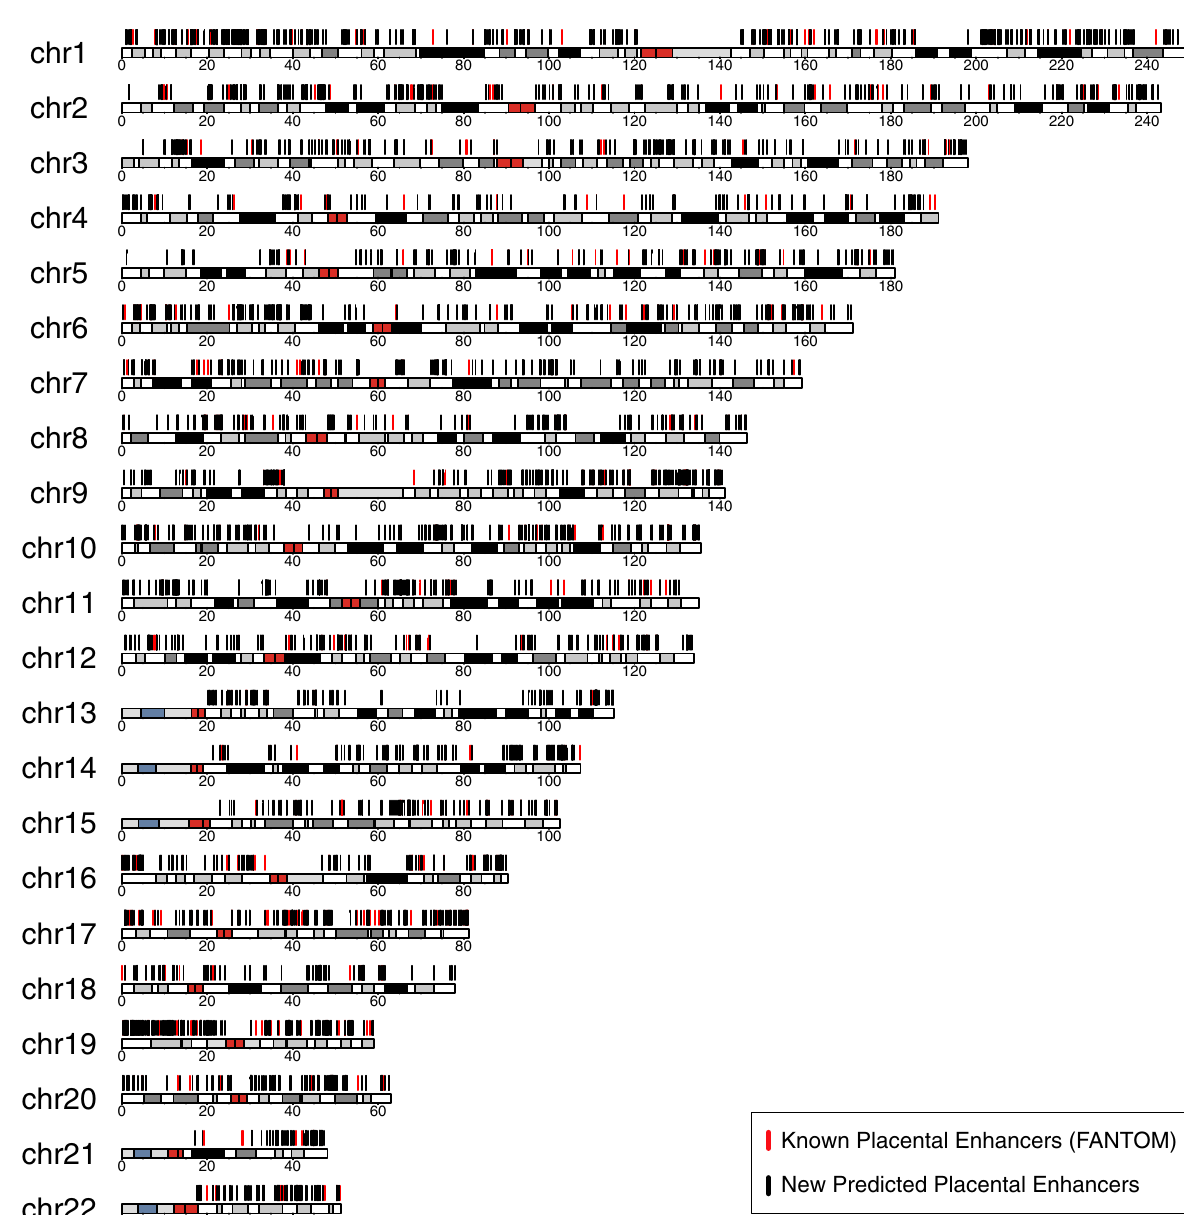
Fig 4. High-confidence predicted placental enhancers are found across the human genome. We predicted 4,562 high confidence placental enhancers and 33,010 potential placental enhancers (S1 and S2 Files). The black lines indicate the locations on human chromosomes (hg19) of our high-confidence predicted placental enhancers. The locations of known FANTOM5 placental enhancers are indicated with red lines. The chromosome ideograms are colored based on cytobands defined by the UCSC Genome Browser: red regions are centromeres; white bands are Giemsa negative regions; and Giemsa positive regions are colored on a gradient from gray to black. The highly variable and tightly constricted (stalk) regions on the p-arms of the acrocentric chromosomes (13, 14, 15, 21, 22) are colored gray and blue, respectively; these arms do not have sequence available for